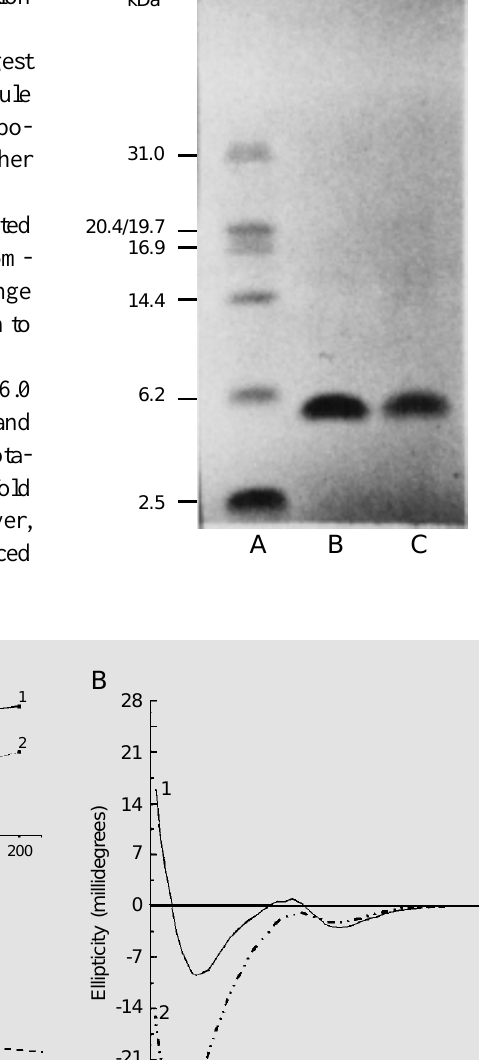
Figure 3. SDS-PAGE of native and irradiated crotamine. A , Mo- lecular weight markers (carbonic anhydrase: 31 kDa, soybean trypsin inhibitor: 20.4/19.7 kDa, horse heart myoglobin: 16.9 kDa, lysozyme: 14.4 kDa, myo- globin fragment (F2): 6.2 kDa, myoglobin (F3): 2.5 kDa). B , Na- tive crotamine and C , irradiated crotamine.